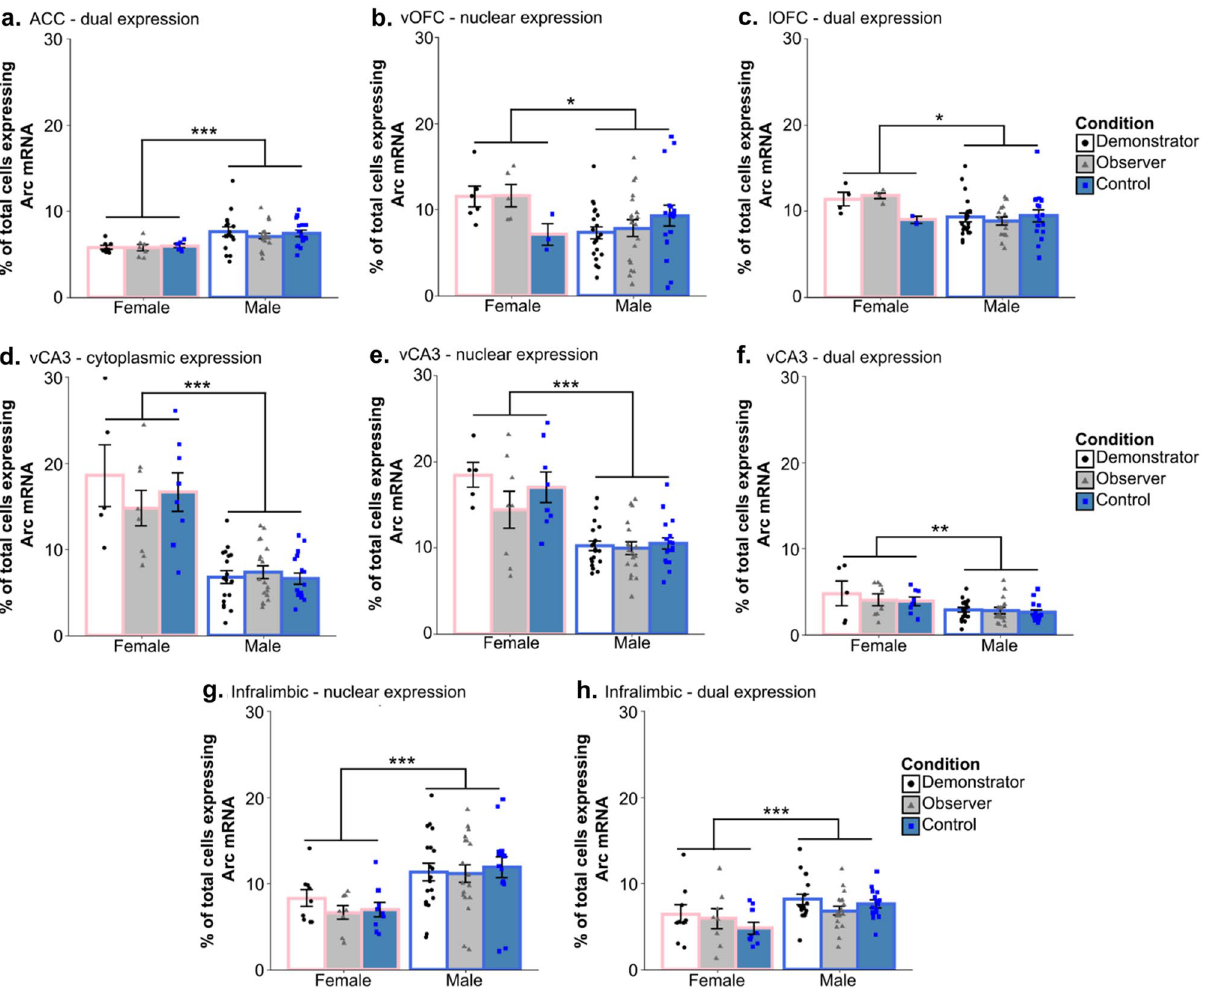
Figure 6. Differences in Arc expression between male and female rats. Significant differences in Arc expression were seen between male and female subjects when comparing ( a ) dual Arc expression in the CG1 region of the anterior cingulate cortex, ( b ) nuclear Arc expression in the ventral orbitofrontal cortex, ( c ) dual expression in the lateral orbitofrontal cortex, ( d ) cytoplasmic, ( e ) nuclear, and ( f ) dual Arc expression in the vCA3 of the hippocampus, and ( g ) nuclear and ( h ) dual Arc expression in the infralimbic cortex. Values represent the mean ± SEM. + p < 0.1, *p < 0.05, **p < 0.01, ***p < 0.001.